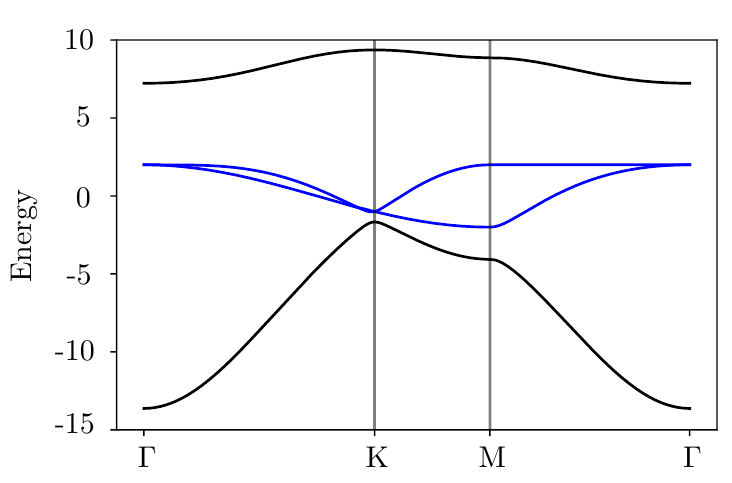
Figure 1: The concept of adiabatic transport is applicable to band structures defined in the reciprocal space of a periodic system, where the vector k in the Brillouin Zone plays the role of the set of parameters λ . In this figure, we show an example of such an application: the blue bands form the family of states the projector P ( k ) , which are separated from states belonging to the rest of bands